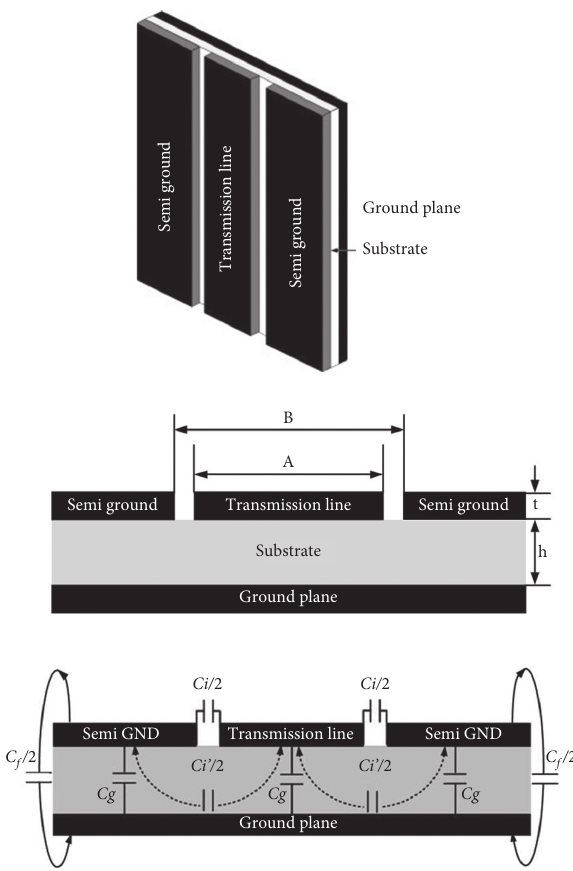
Figure 1: Structure of CPW with ground plane and all capacitive